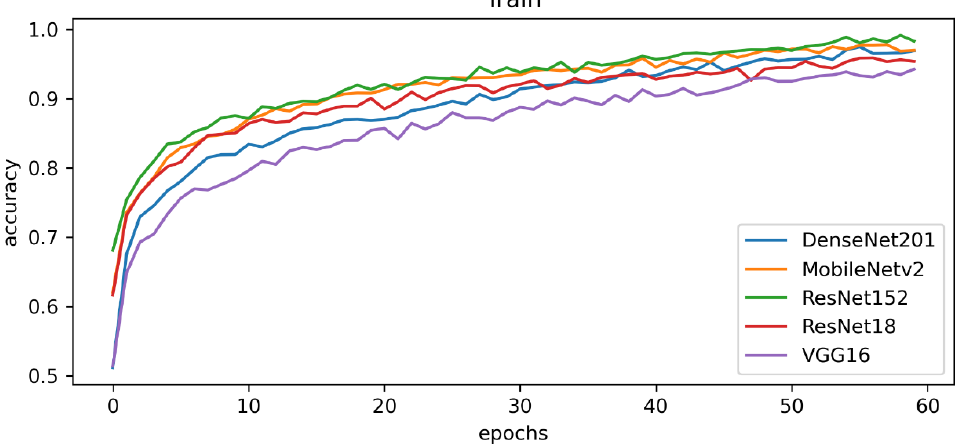
Figure 4. Train accuracy of the CNN models for the backbone of explainable AI.